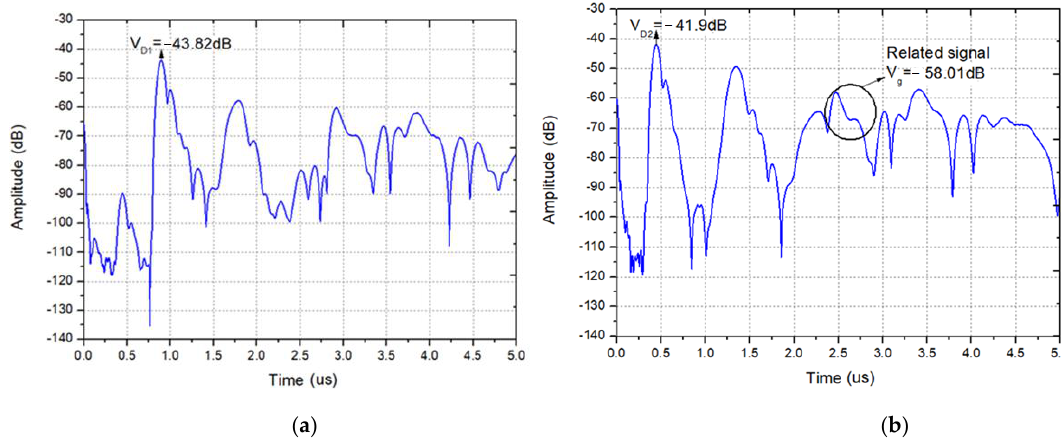
Figure 7. The pulse responses in time domain from T 2 to T 3 ( a ) and T 1 to T 3 ( b ).